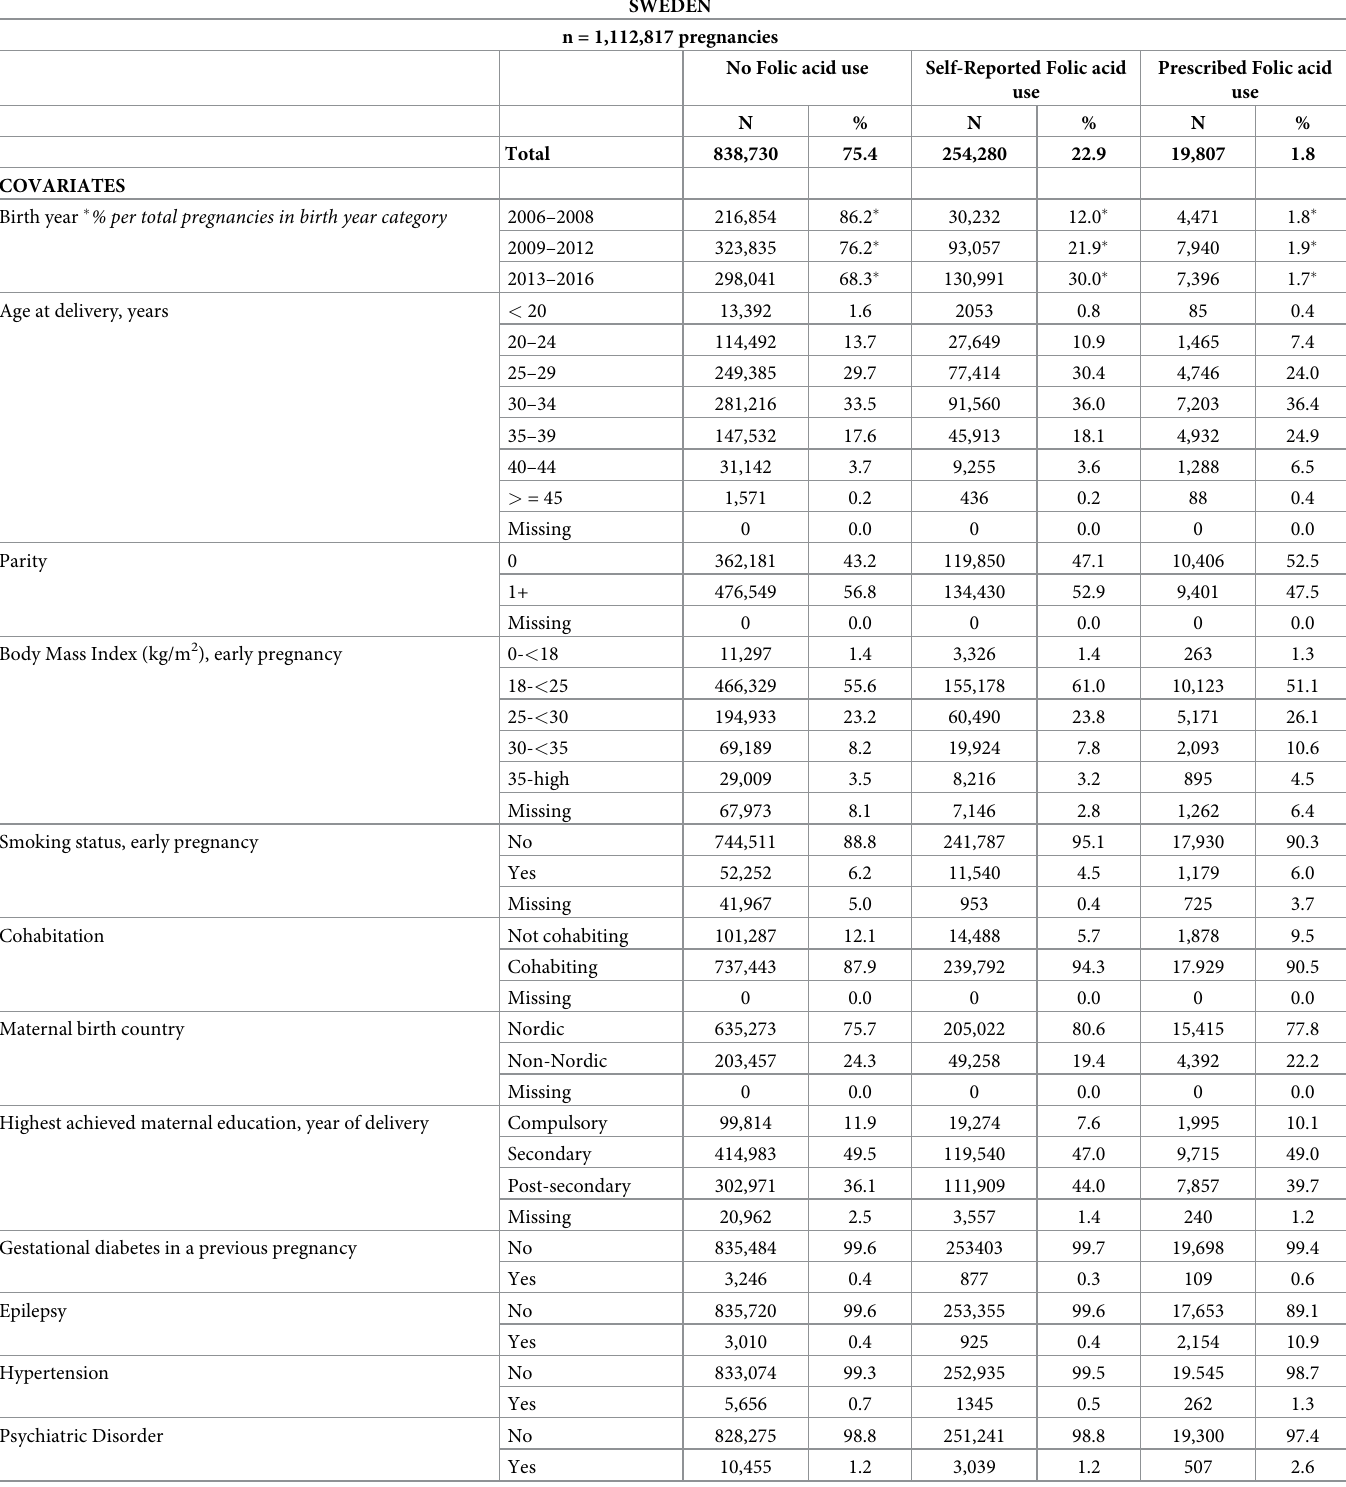
Table 2. Characteristics of study population from Sweden including all pregnancies from mothers without pre-existing diabetes or pre-pregnancy antidiabetic med- ication use from 1 July 2006 to 31 December 2016.